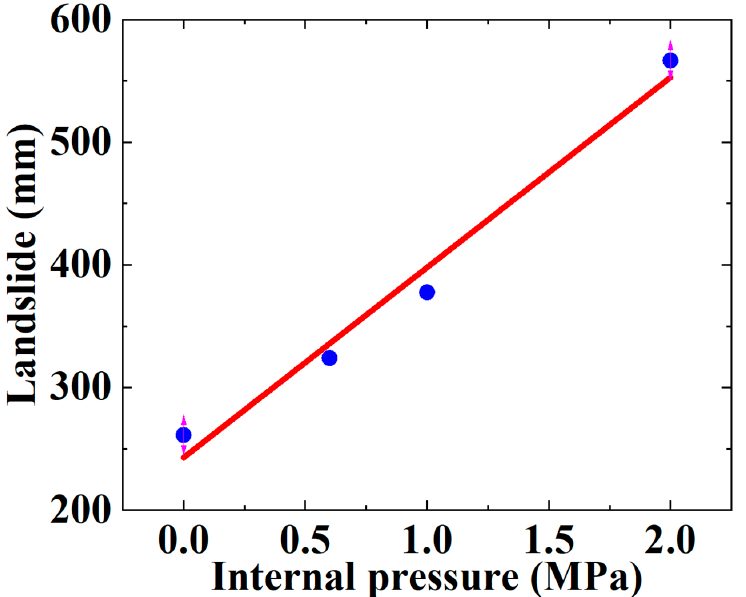
Figure 23. Influence of internal pressure on the maximum landslide of SWW-RTP.